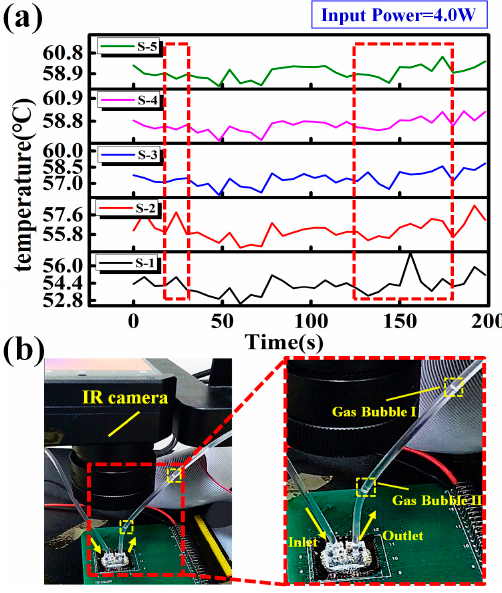
Figure 7. ( a ) Transient temperature responses at different locations for Case II (input power = 4.0 W) and ( b ) pictures of gas bubbles observed from the outlet.